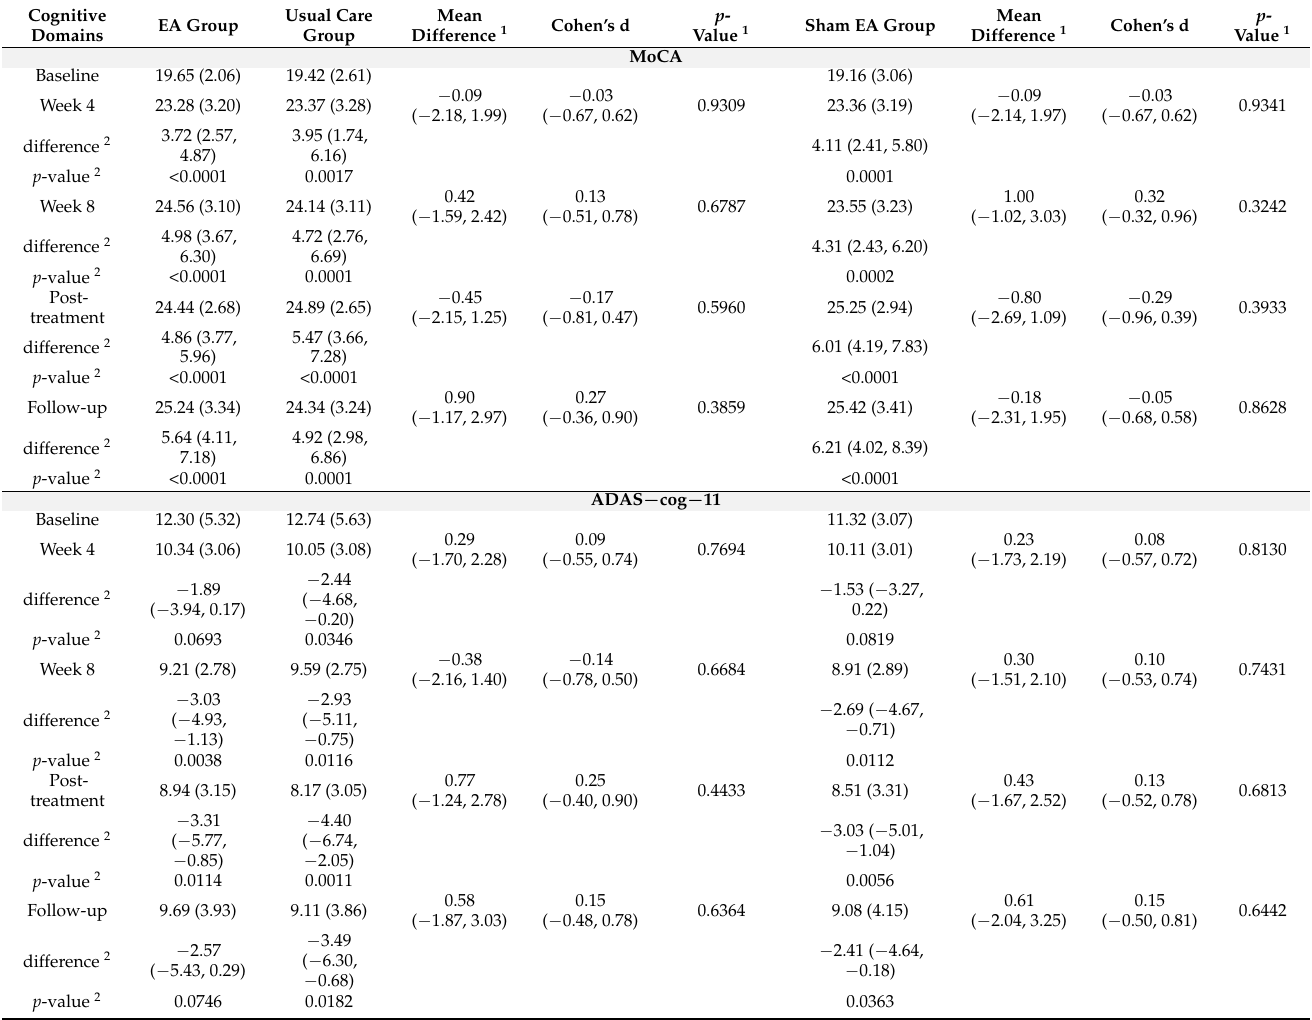
Table 3. Effects of 12-week EA Treatment on MoCA and